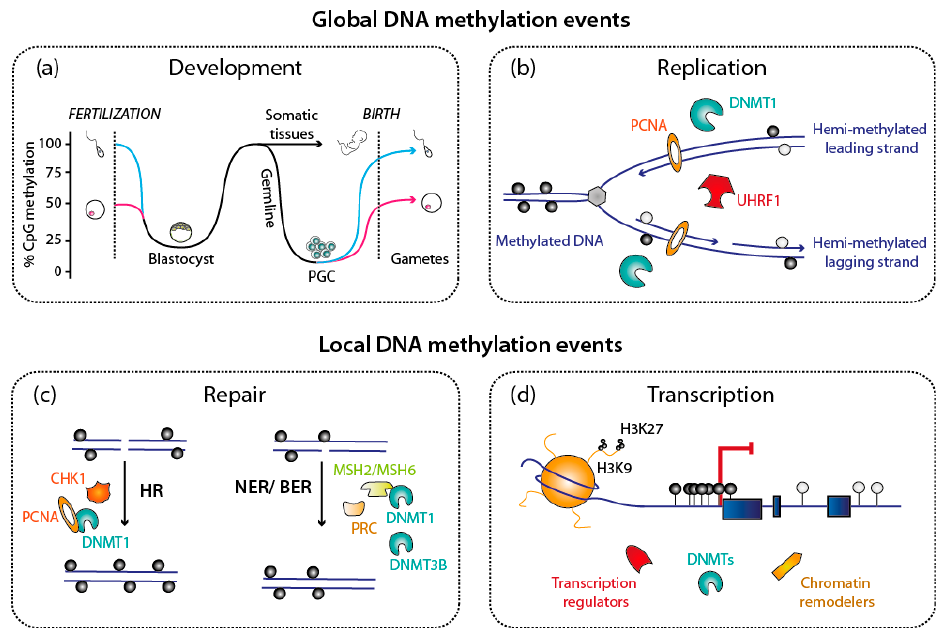
Figure 2. Biological processes involving DNA methylation, DNA methyltransferases (DNMTs) and keys partners. DNA methylation is involved in regulating many cellular processes; for all of them, DNMTs cooperate with several essential actors. ( a , b ) These DNA methylation events can affect the whole genome, as during the two methylation waves during mammalian life cycle, but also after DNA replicates at each cell cycle. ( c , d ) DNA methylation events can also be localized, as on the newly synthesized DNA after DNA repair. Selected examples, depicted in this cartoon, will be discussed further in this article. Abbreviations used: PGC: Progenitor germ cells; HR: Homologous Recombination; NER: Nucleotide Excision Repair; BER: Base Excision